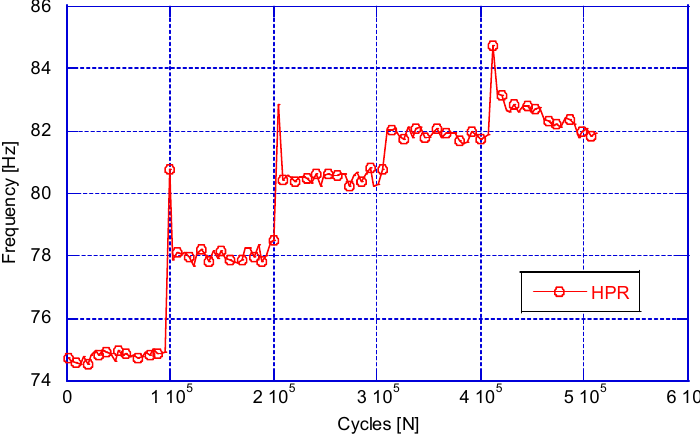
Figure 7. Resonance fatigue frequency evolution during a Locati test. Figures 8 and 9 show an example of the comparison between the test frequencies obtained for each type of concrete as a function of the percentage of NA replaced by MRA for each type of cement.